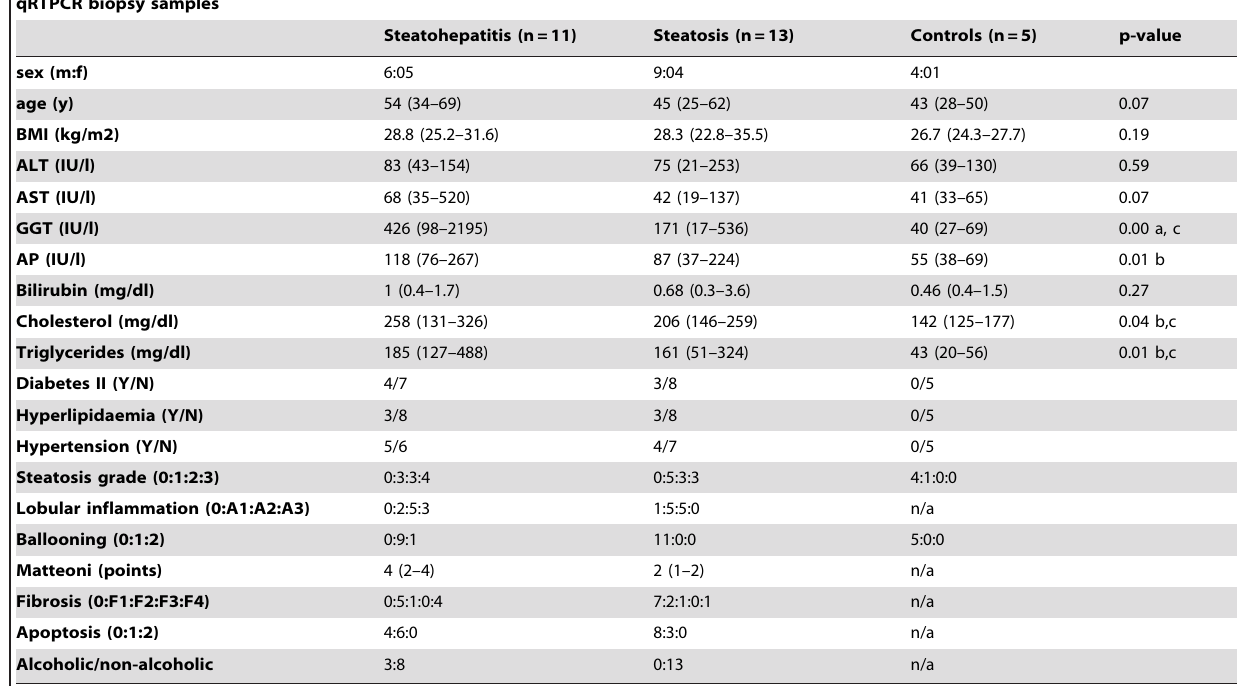
qRTPCR biopsy samples